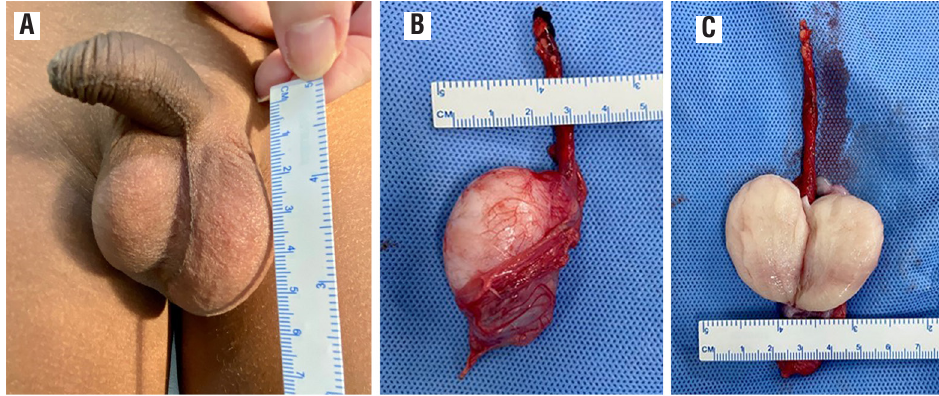
Figure 1 - Early left testicular recurrence in a 4-year-old